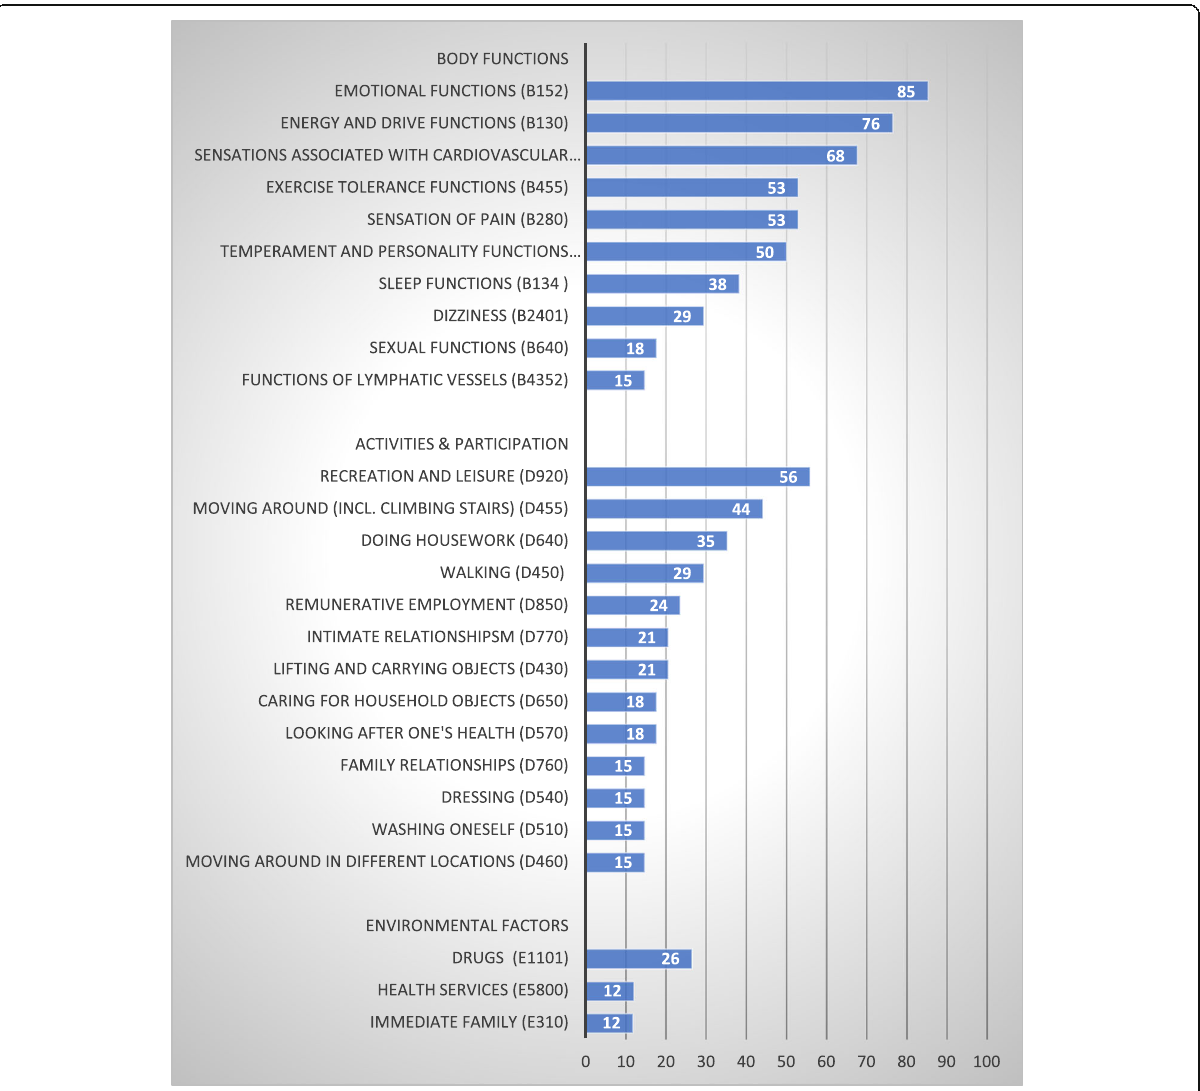
Fig. 2 Most frequently mapped ICF categories (in percent) across the 34 PROMs with the results stratified by Body functions , Activities & Participation , and Environmental